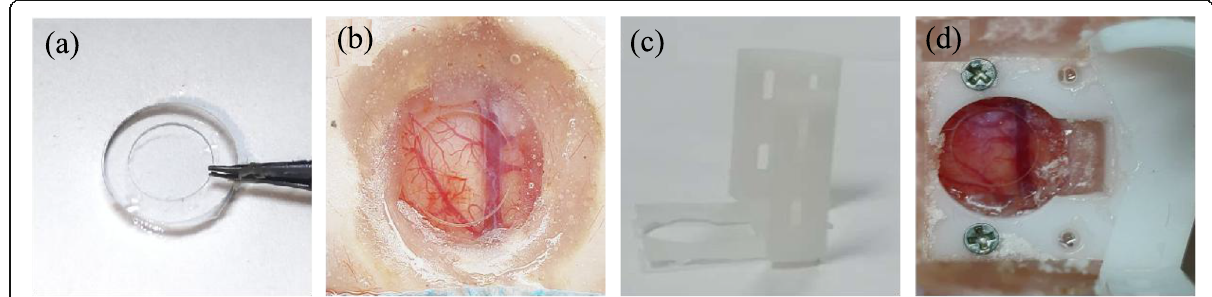
Fig. 6 a Photograph of the PDMS-based cranial window implant [62]. b A photograph of the cranial window for PA imaging in an anesthetized